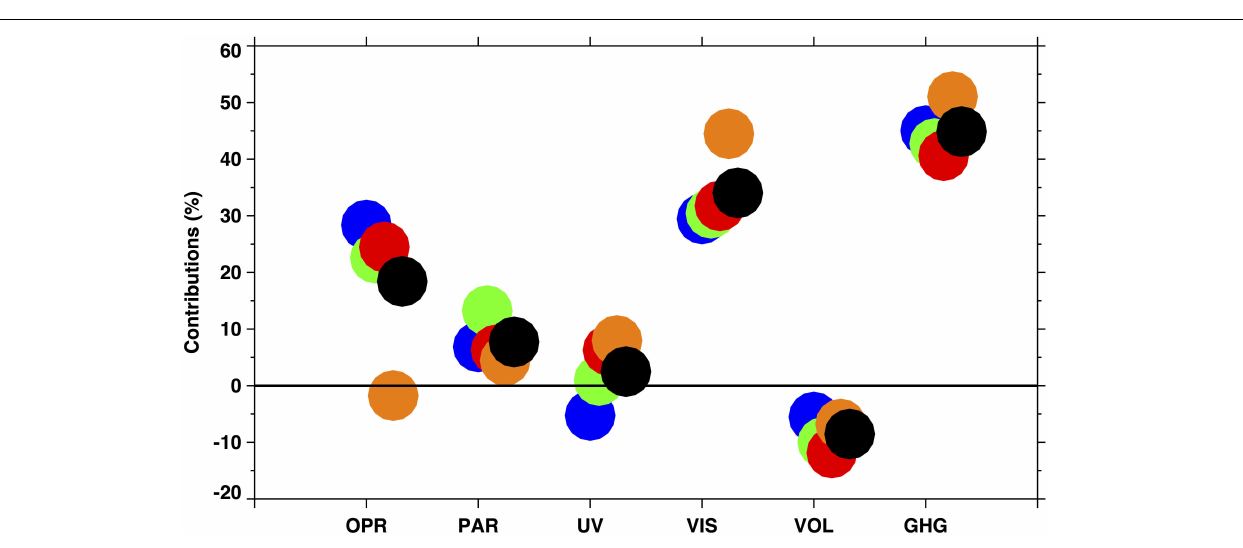
FIGURE 5 | Contribution (%) of different forcing agents to global and seasonal mean temperature trends for the period 1910–1940 from the reference simulation (ALL). Black, blue, green, red, and orange colors present annual, DJF, MAM, JJA, and SON season